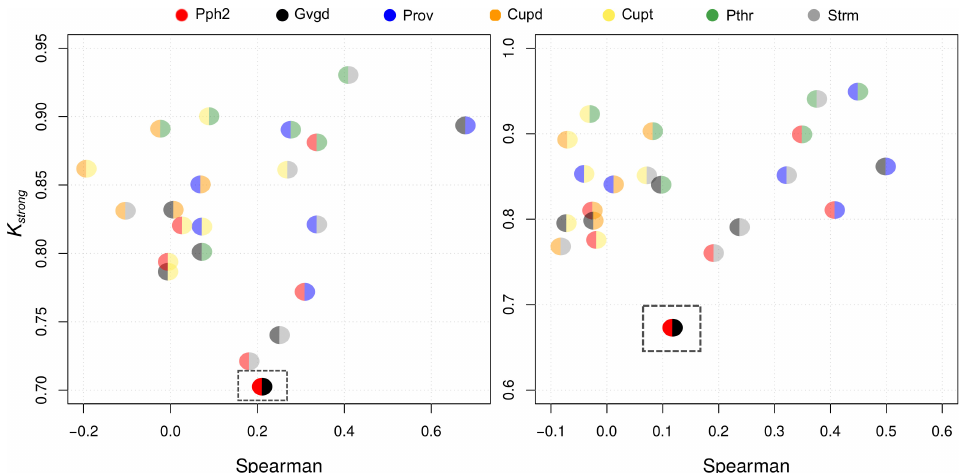
Figure 3. K strong vs. Spearman for the BRCA1-SGE (left) and BRCA1-HDR (right) datasets. The bottom rectangles point out the less correlated p-tools according to K strong .